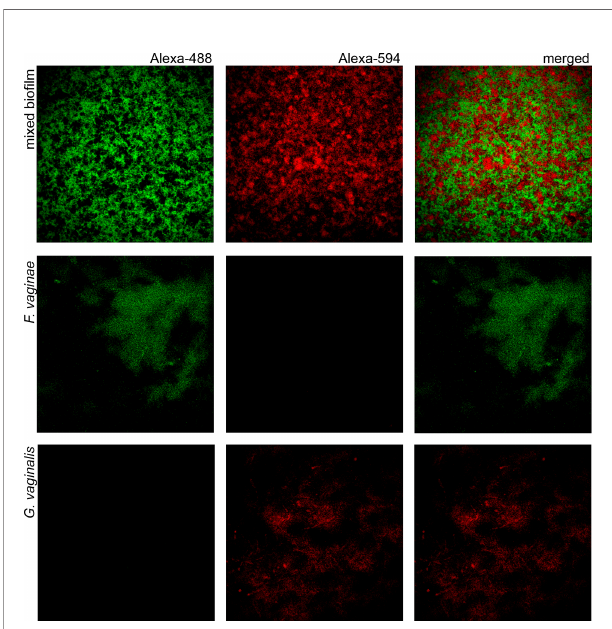
FIGURE 2 | Confocal Laser Scanning Microscopy images of single- and dual-species bio fi lms hybridization with Gard162 and FvagPNA651 probes. Gard162 probe detected G. vaginalis 24 h single-species bio fi lm and F. vaginae probe detected F. vaginae 24 h single-species bio fi lm. The probes were able to detect G. vaginalis (red) and F. vaginae (green) on 24 h dual- species bio fi lm. The images were acquired using 40×